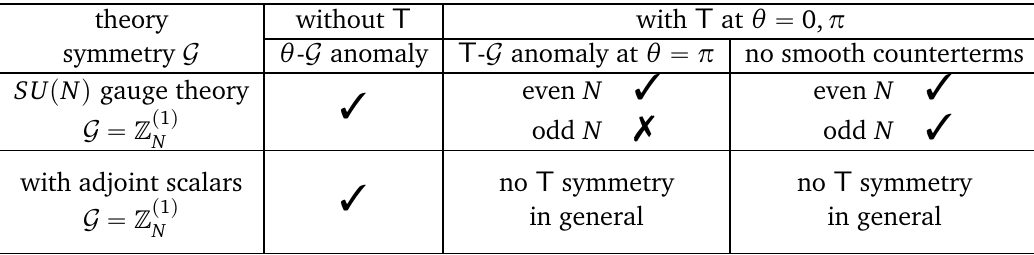
with adjoint scalars no T symmetry in general in